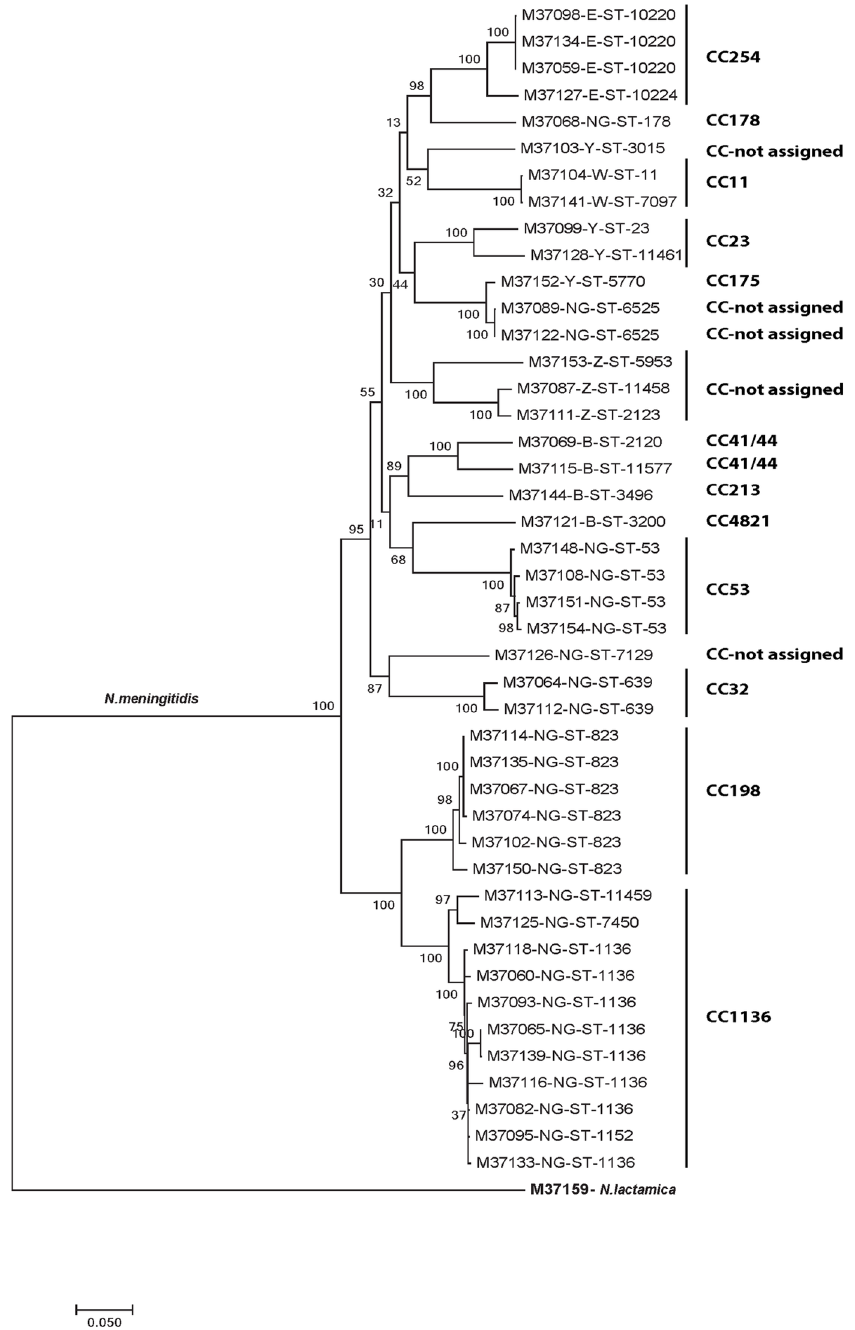
Fig 1. Phylogenetic tree of the N . meningitidis isolates based on the whole-genome sequence data. The N . meningitidis isolates are labelledwith their sample ID, serogroup(SG), sequencetype (ST) and clonal complex (cc). An N . lactamica isolate was used as the outgroup. Internal nodes are labeledwith bootstrap values. The scale bar is basedon the 7131 positionsin the core SNP matrix and indicatednucleotide substitutionsper